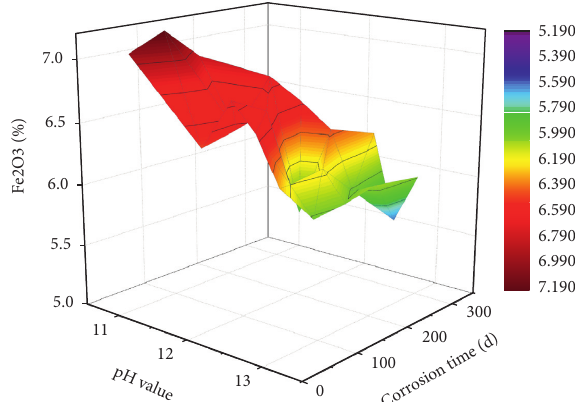
Figure 7: Changes of the Fe 2 O 3 content in the laterite at different alkaline-solution concentrations and permeation times.